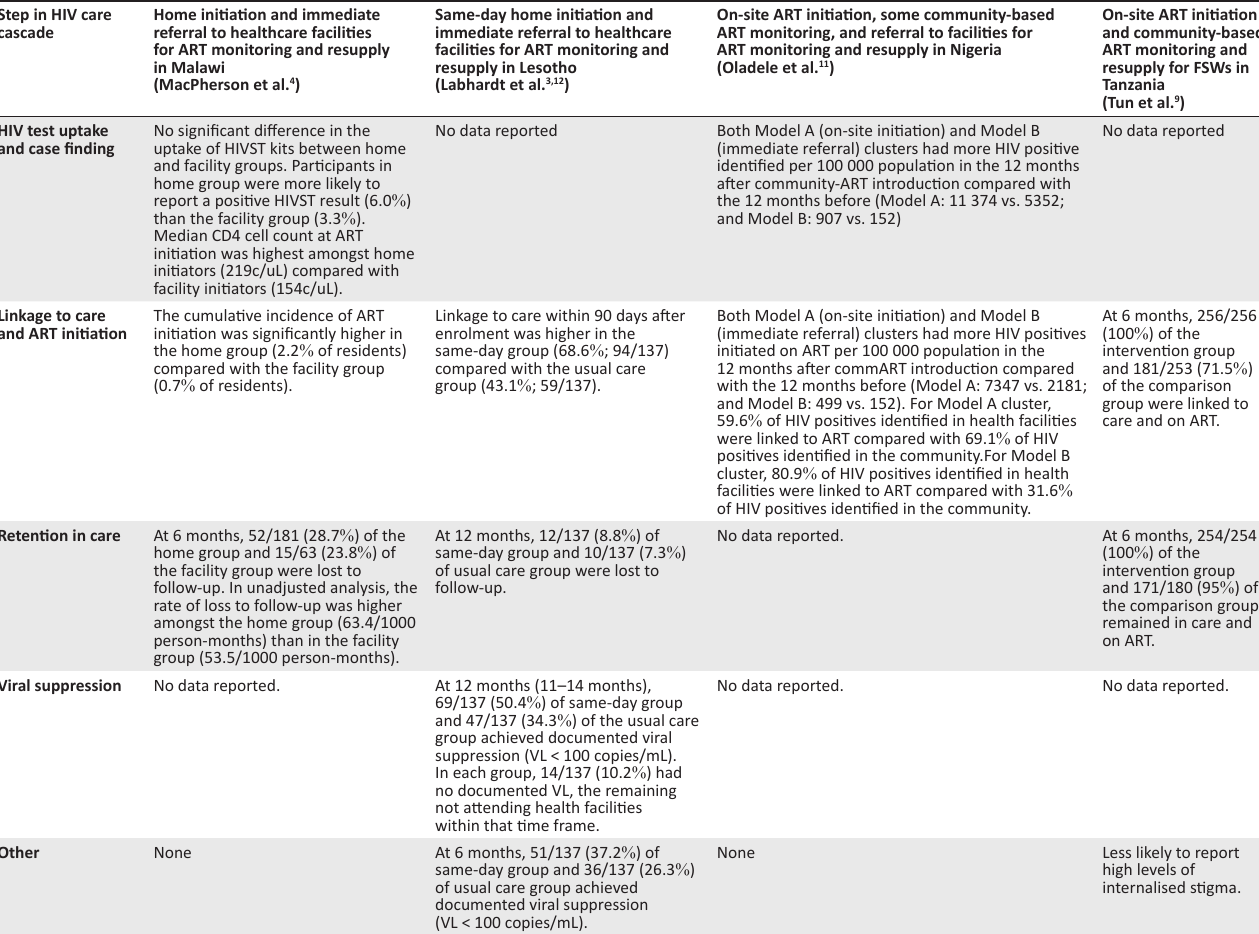
TABLE 3: Effectiveness of community antiretroviral therapy initiation models identified. Step in HIV care